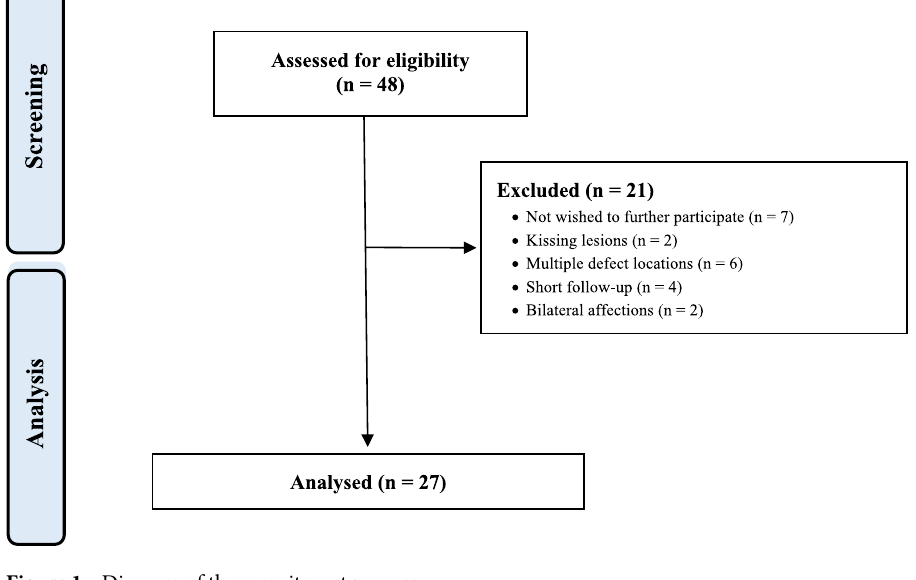
Figure 1. Diagram of the recruitment